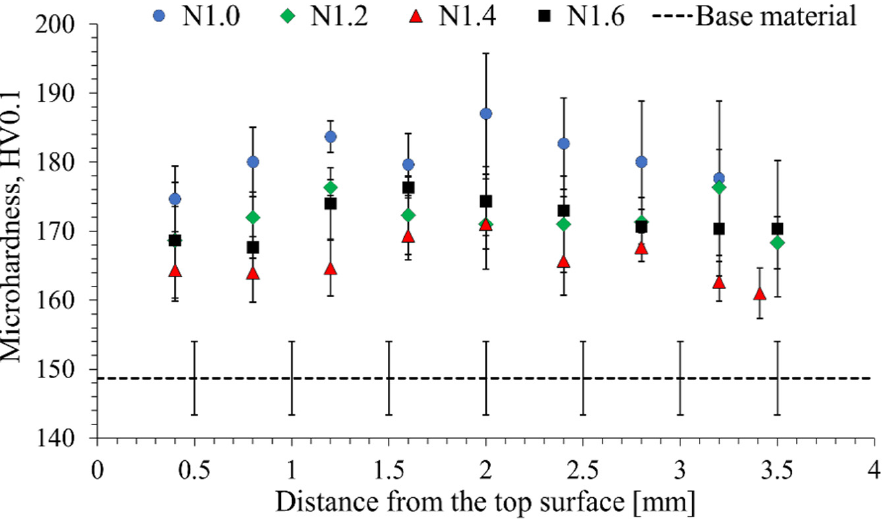
Figure 3. Distribution of microhardness in the samples rolled at room temperature.